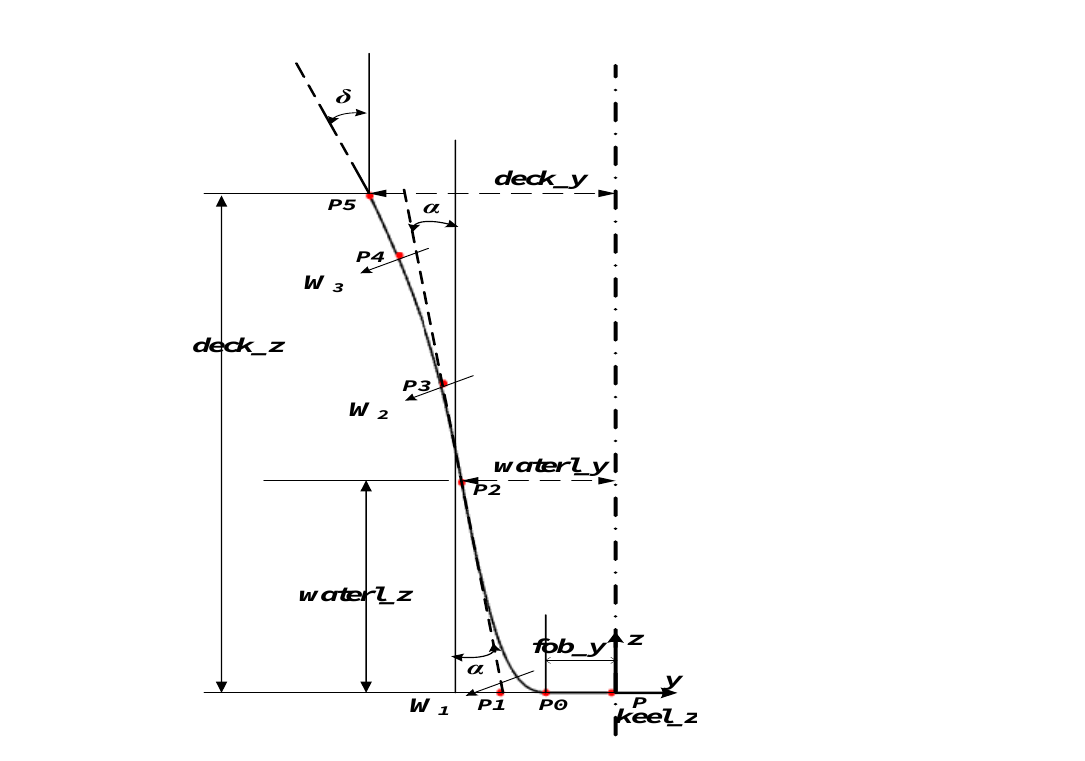
Figure 6. Geometric significance of the third category of characteristic parameters.